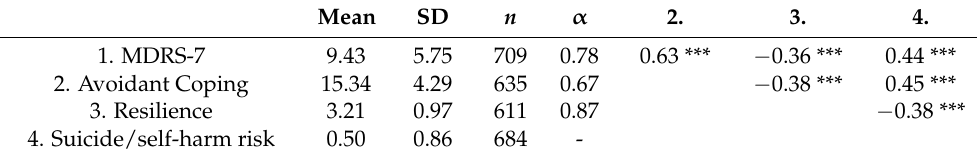
Note. *** indicates significance at p <